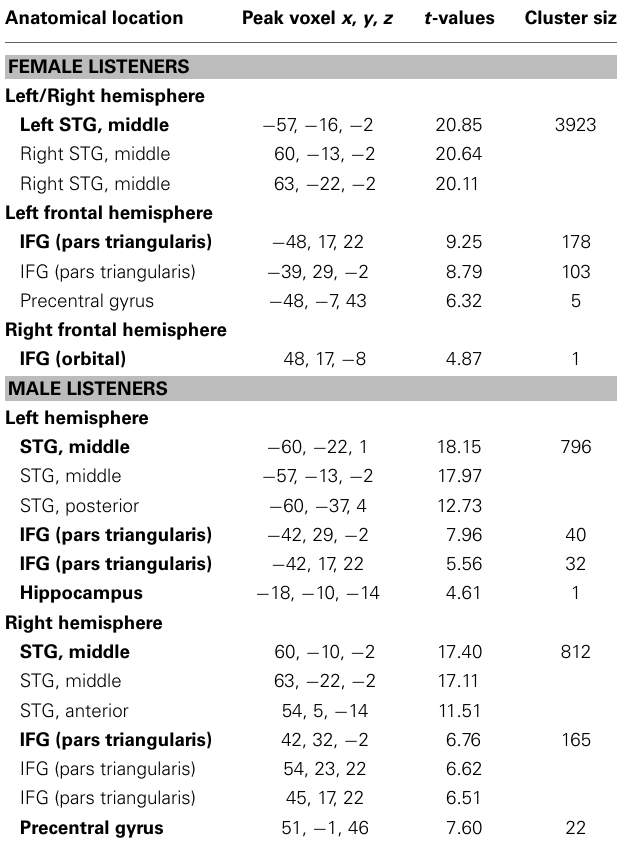
Table 1 | Voice-sensitive peak voxels of female and male RFX analysis (Univariate).